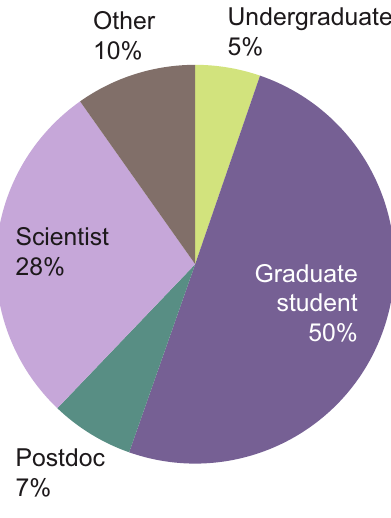
Figure 1. Demographic breakdown of researchers surveyed. n = 133.